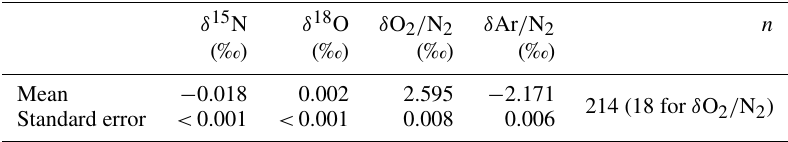
Figure 8. Atmospheric composition measured against reference gas for (a) δ 15 N, (b) δ 18 O, (c) δ O 2 / N 2 and (d) δ Ar / N 2 . Open markers represent individual data points, whereas filled markers represent the means of values measured within several days (error bars are 1 SD). Grey plus ( + ) markers in panel (d) represent estimated δ O 2 / N 2 of MTS-2017 against reference gas through the measurements of STD-A against the reference gas, assuming that δ O 2 / N 2 of STD-A has not changed. Vertical grey lines indicate the timing of replacements of the reference can, and vertical light blue lines indicate the timing of filament replacements. Table 5. Composition of STD-A for mass spectrometer